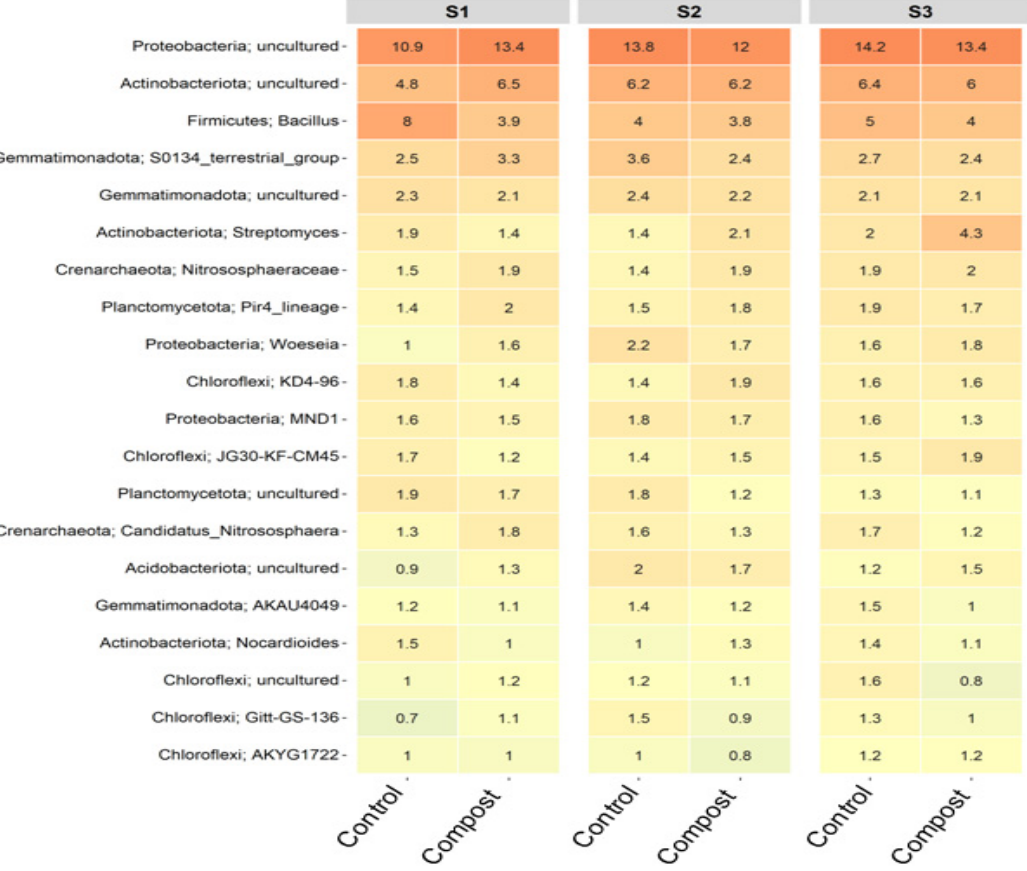
Figure 4. The heatmap of the correlation between bacterial phyla and treatments at tillering (S1), booting (S2) and ripening stage (S3).